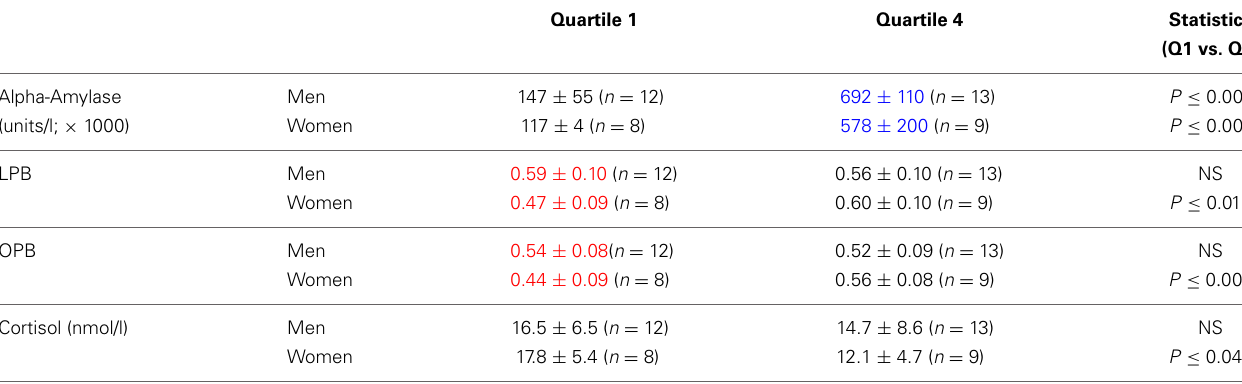
Table 2B | Risk-taking parameters and salivary cortisol levels (mean ± SD ) in men and women calculated according to alpha-amylase-related quartiles (see